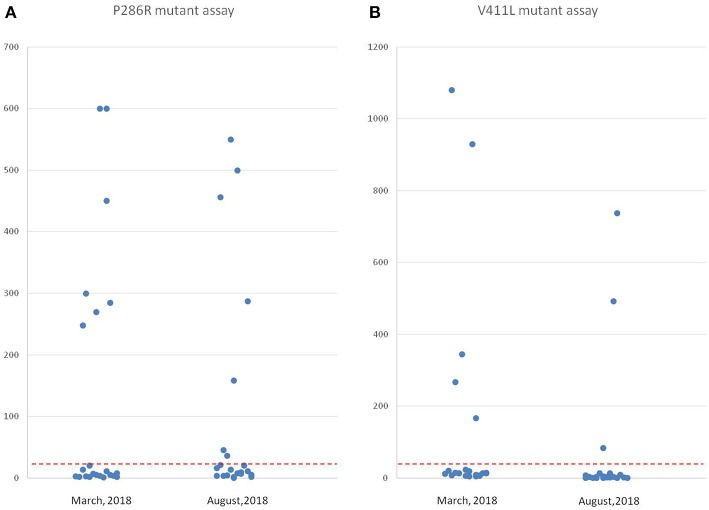
Comparison of point mutation signals detected by in situ hybridization 5 months before and after in paraffin sections using two probes. (A) The values of the positive signal of POLE P286R mutations from the same group of high-grade EC tissues at two time points (22 cases). The left side is the result from March 2018, and the right side is the result from August 2018 (the number of positive signals decreased). (B) The values of the positive signal of POLE V411L mutations from the same group of high-grade EC tissues at two-time points (22 cases). The left side is the result from March 2018, and the right side is the result from August 2018 (the number of positive signals decreased remarkably, and the signal values of two cases fell below the threshold).